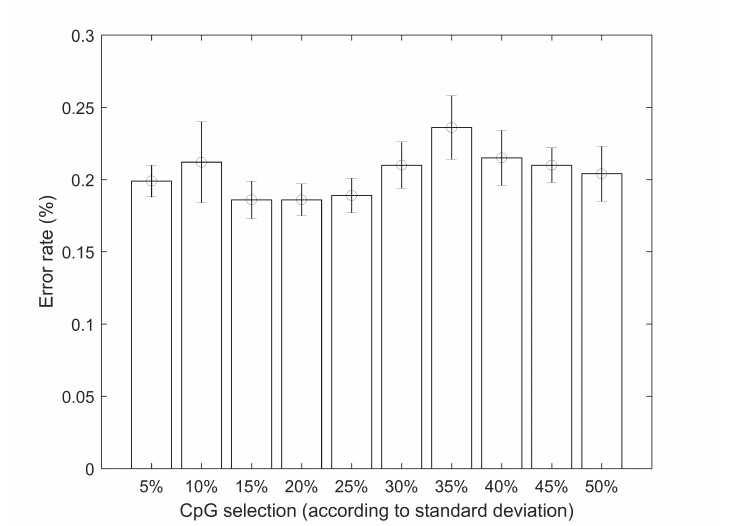
Figure 8. Sensitivity analysis according to the standard deviation of the value of the CpGs. Error rate as a function of the amount of CpGs selected according to their standard